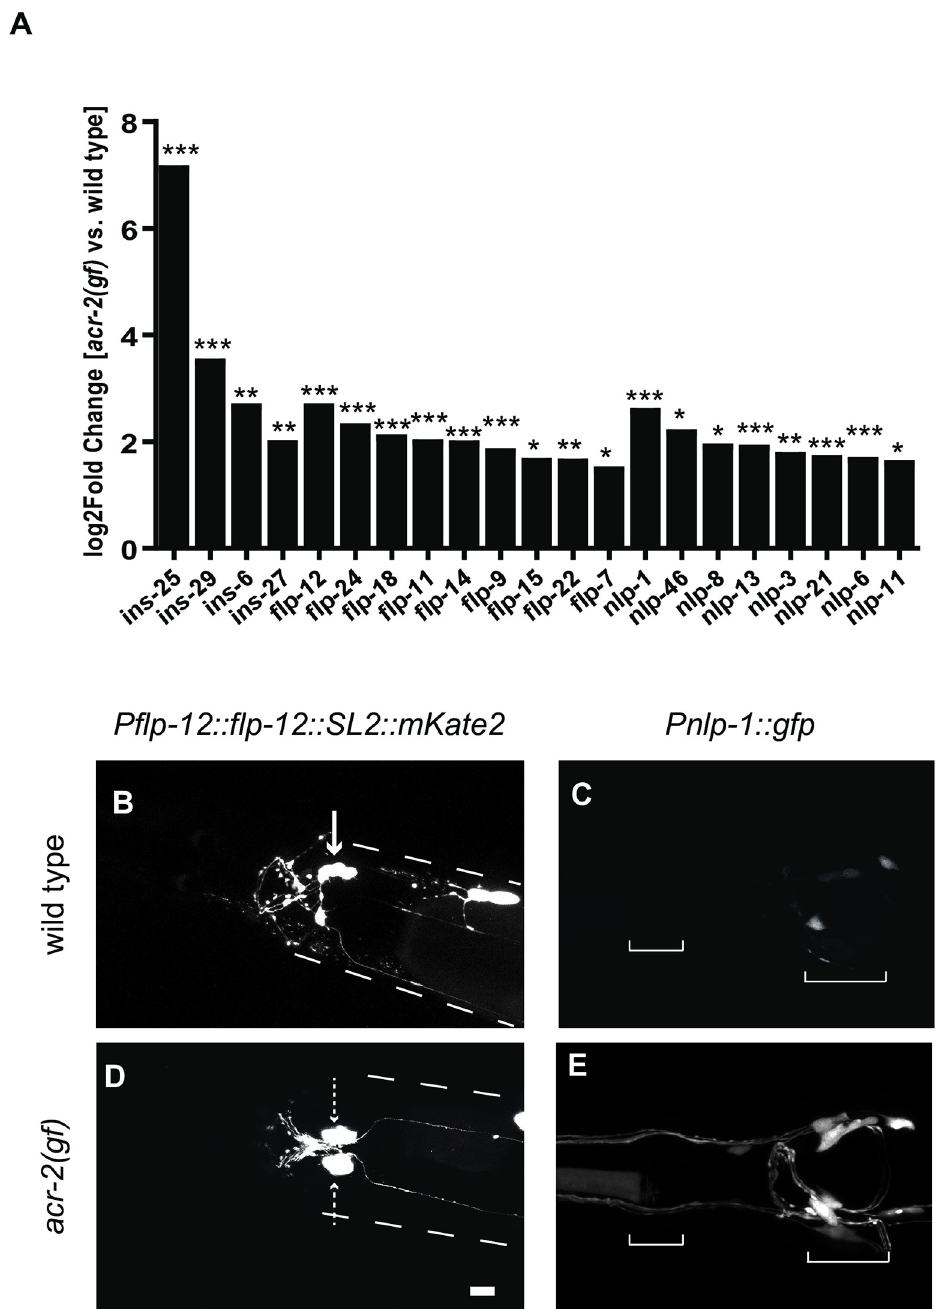
Fig 2. Neuropeptides are up-regulated in head neurons in acr-2(gf) animals. A. Log 2 (Fold Change) values for all up- regulated neuropeptides in acr-2(gf) animals are shown, grouped by class, as identified with DESeq2 analyses. Neuropeptides of each class were affected. ( � P < 0.05, �� P < 0.01, ��� P < 0.001). B-E. Differential expression of neuropeptide transcriptional reporters in the head of acr-2(gf) animals compared to wild type. (B,D) The arrow points to the SMB neuron expressing the P flp-12 transcriptional reporter ( juEx7964 ) in wild type based on shape and location. Dashed arrows point to the bilateral pair ectopically expressing the reporter in acr-2(gf) . Dashed lines indicated approximate outline of the animal. The posterior fluorescent signal in both strains is the co-injection marker labeling coelomocytes.(C,E) Pnlp-1 :: gfp (juEx7879) expression is both increased in the same cells as wild type and also ectopically expressed. Brackets delineate the anterior and posterior pharyngeal bulbs, respectively.